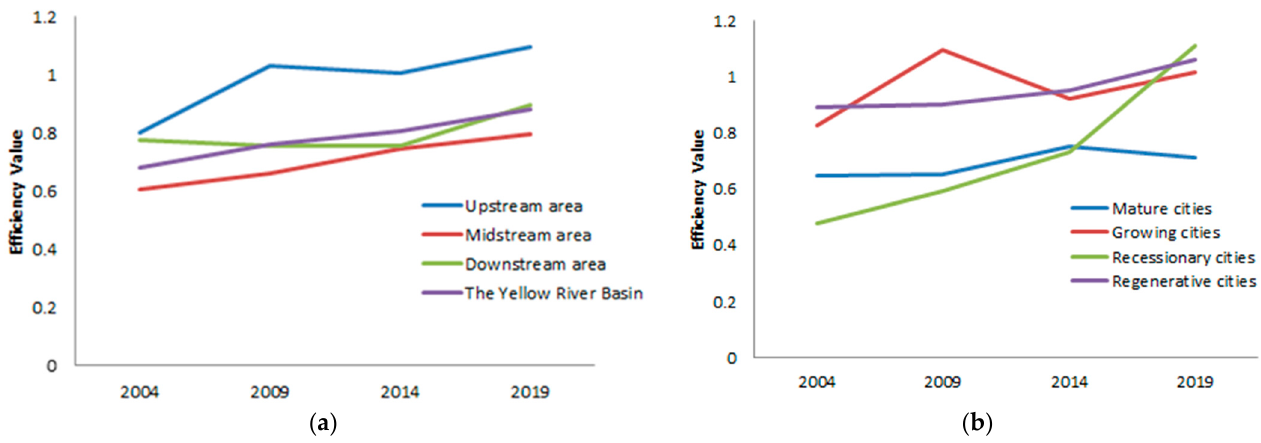
Figure 3. GLUE of the resource-based cities in the YRB. ( a ) GLUE of each area; ( b ) GLUE of each type.